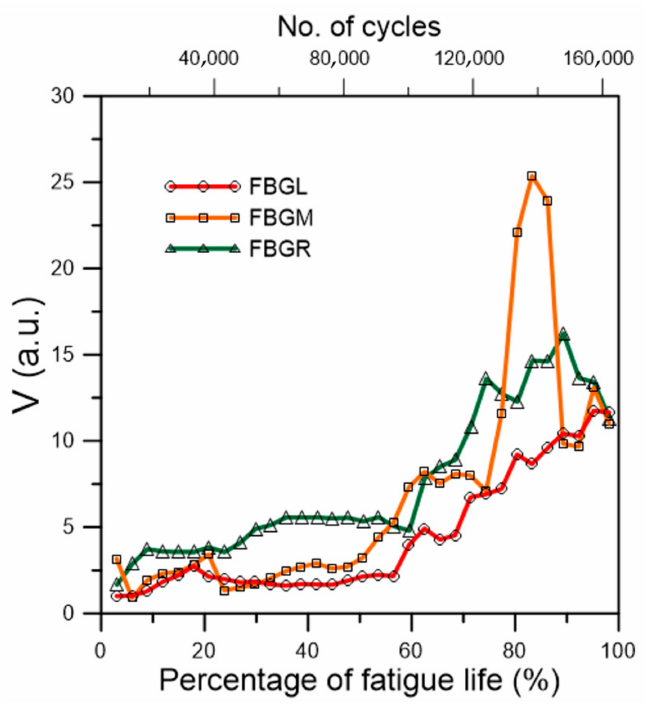
Figure 10. Evolution of the V values of the three FBG unload spectra during fatigue cycling of a virgin